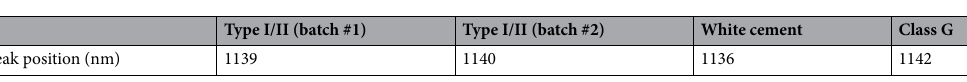
Table 1. Luminescence spectral peaks from different cement